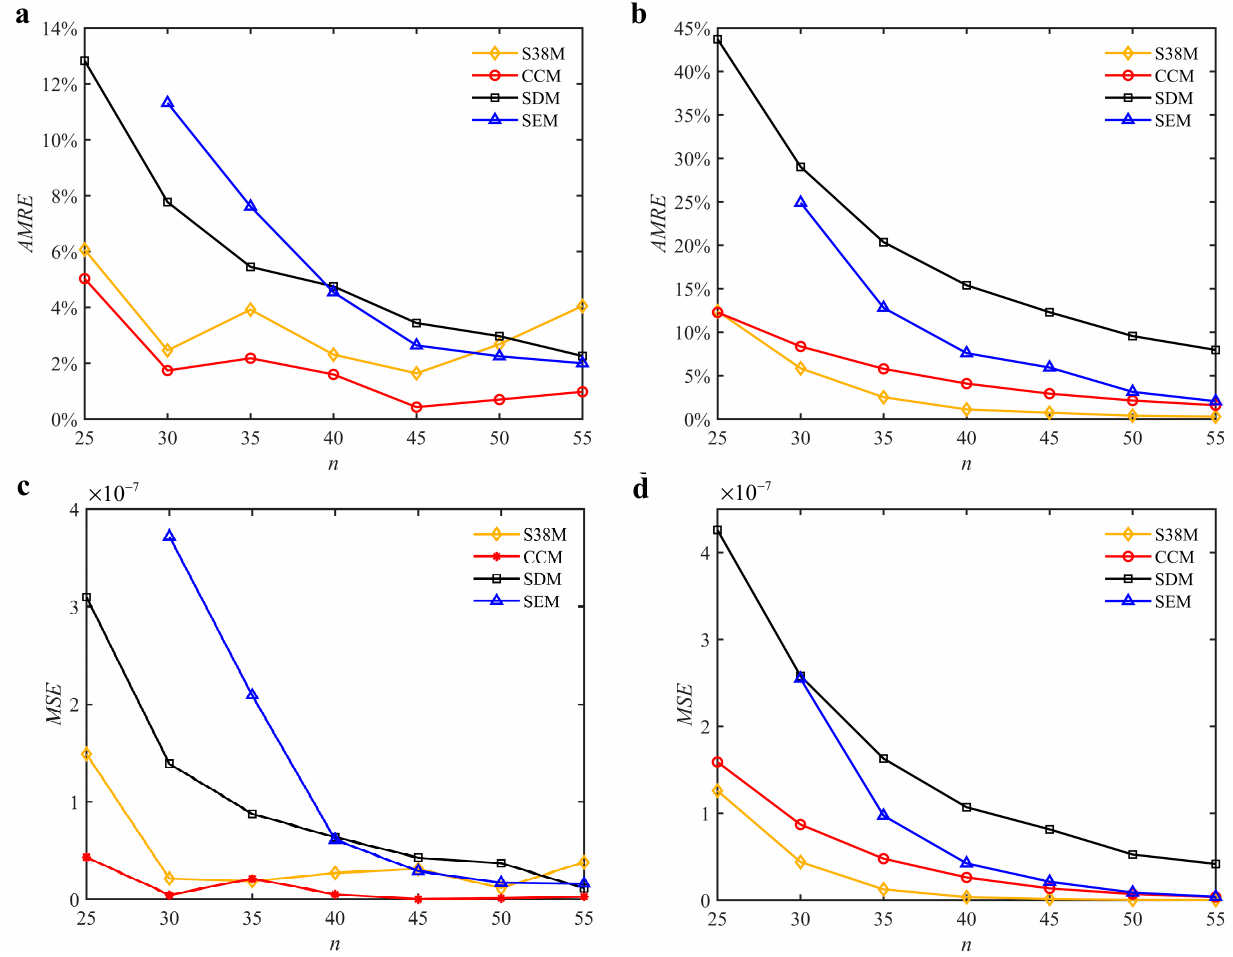
Figure 10. AMRE and MSE of the S38M, CCM, SDM, and SEM. ( a ) AMRE when a / D = 0.05; ( b ) AMRE when a / D = 1; ( c ) MSE when a / D = 0.05; ( d ) MSE when a / D = 1.